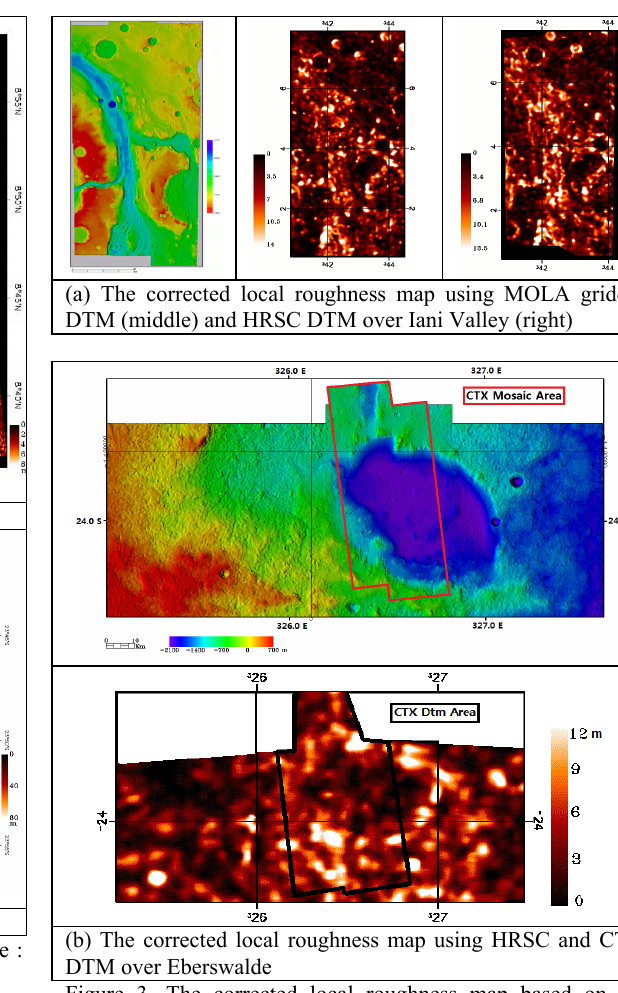
Figure 3. The corrected local roughness map based on the MOLA beam broadening